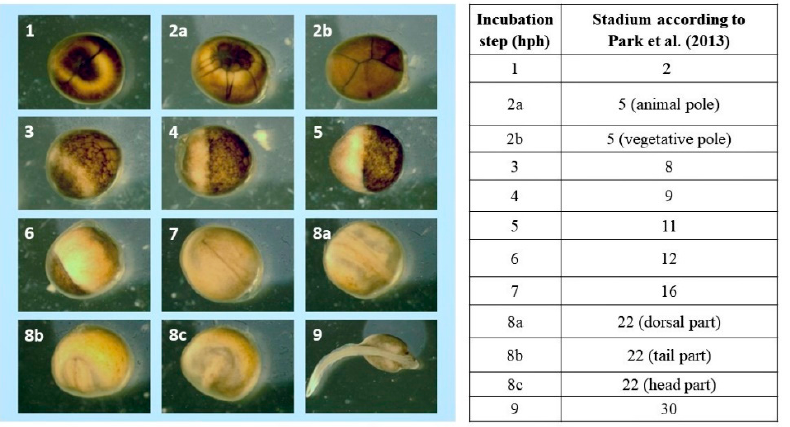
Figure 2. Embryonic development of hybrids [ ♀ Siberian sturgeon × Russian sturgeon] × ♂ Siberian sturgeon offspring (group B) according to Park et al. [10].